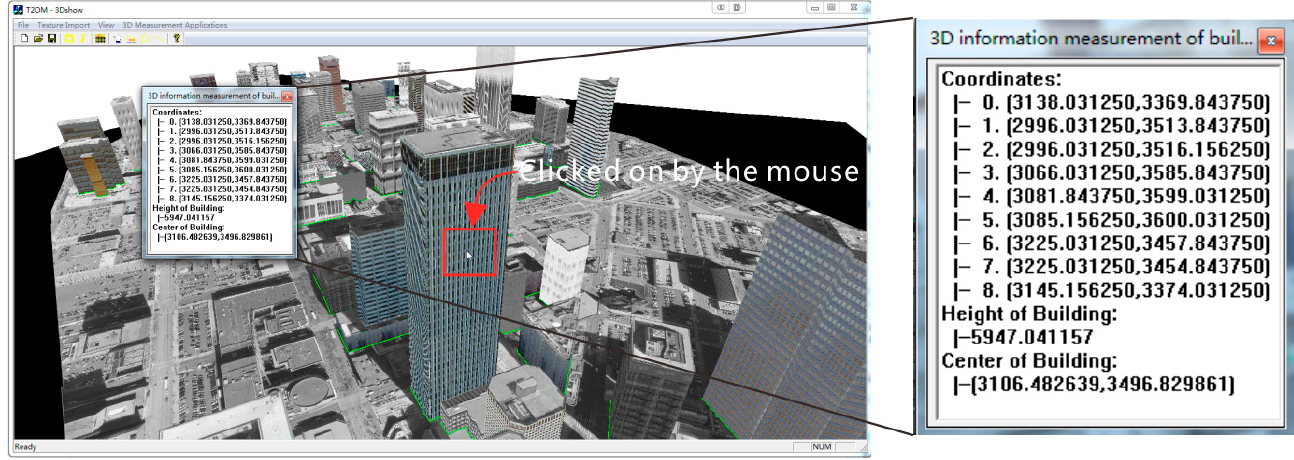
Figure 24. View information about the building.